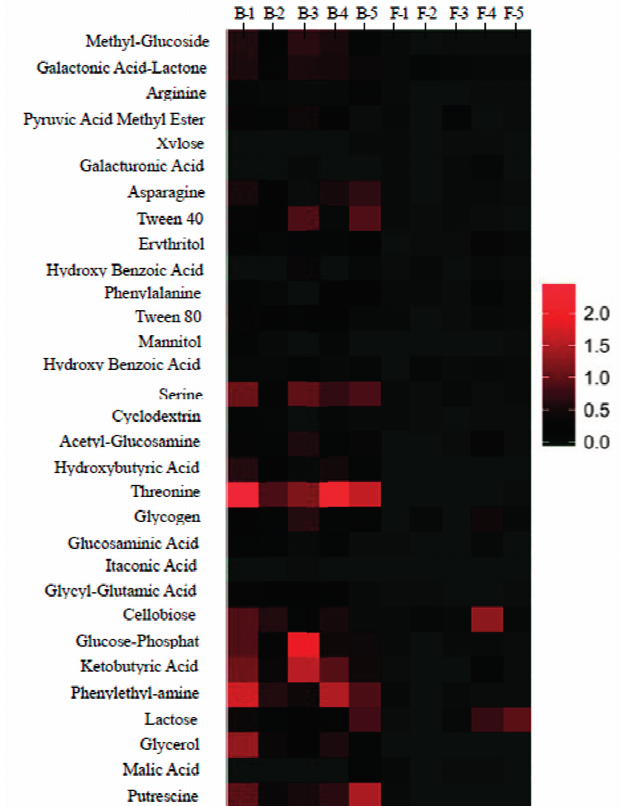
Figure 3. Heat map fingerprints of water bacterial community utilized different sole carbon substrate in the tap water collected from building taps before flushing (Before) and flushing for 10 min (Flushed). B-1, B-2, B-3, B-4, and B-5 represent Tap 1, Tap 2, Tap 3, Tap 4, and Tap 5 of water before flushing, respectively. F-1, F-2, F-3, F-4, and F-5 represent Tap 1, Tap 2, Tap 3, Tap 4, and Tap 5 of flushed water,